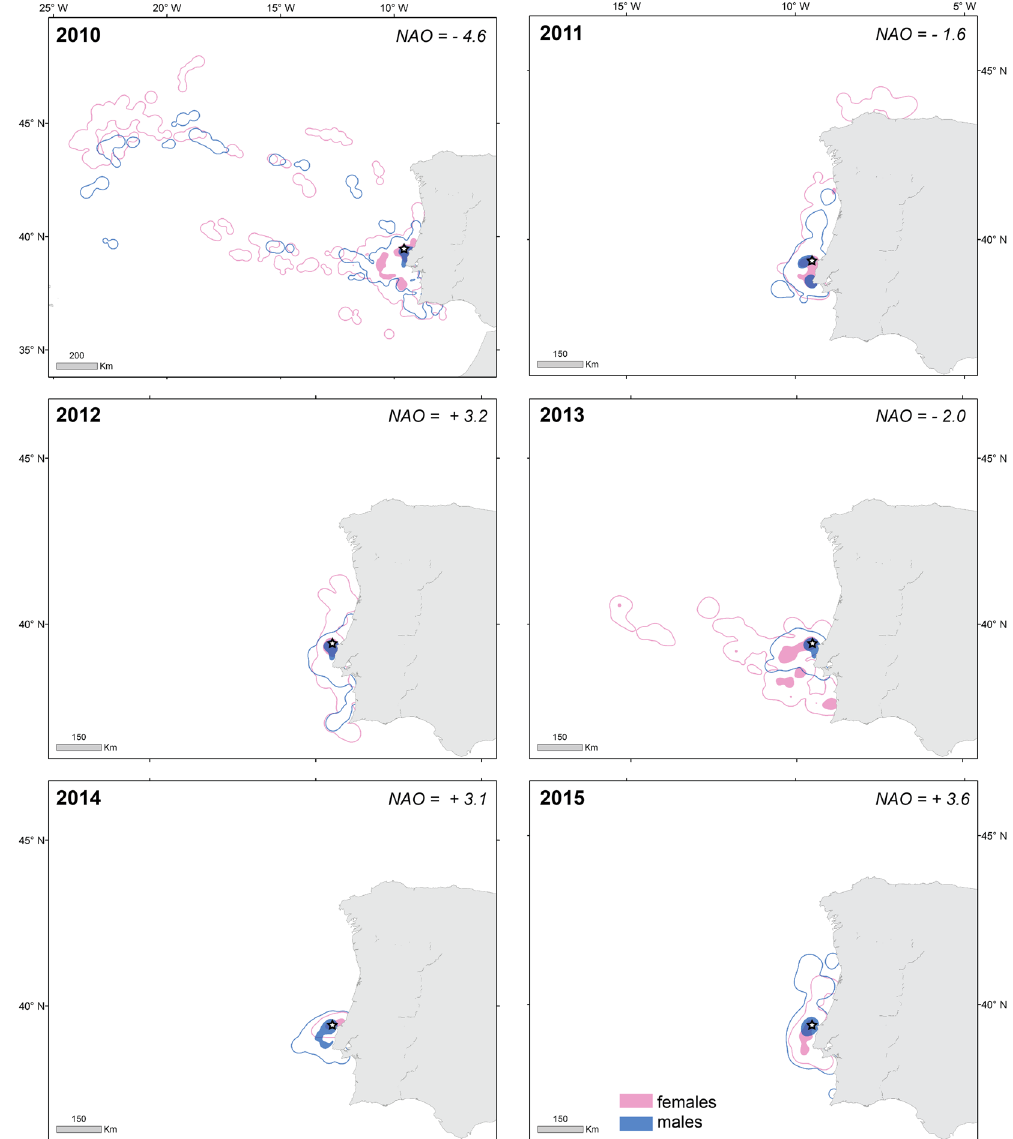
Figure 1. Home range (contour lines; 95% kernel UD) and foraging areas (filled areas; 50% kernel UD) of male (blue) and female (pink) Cory’s shearwaters during the chick-rearing seasons of 2010–2015. Kernel UD polygons generated with adehabitatHR package 44 within the R environment version 3.2 (https://www.R-project. org/) 45 . Berlenga Island (breeding colony) represented with a white star. Also shown at the top-right corner of each map, the value of extended winter (December-March) North Atlantic Oscillation (NAO) index according to Hurrel 1995 (https://climatedataguide.ucar.edu/climate-data/hurrell-north-atlantic-oscillation-nao-index-